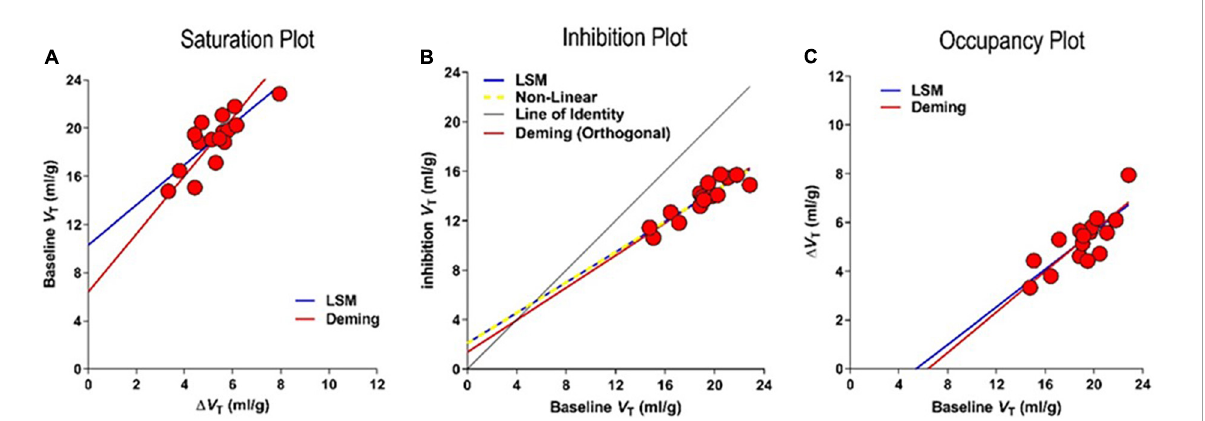
FIGURE11 Competition of tracer [ 18 F]ASEM with unlabeled inhibitors. Results of regressions to three different linearizations of competition plots of effect of unlabeled drug interaction with PET tracer binding in absence of valid reference region. (A) Saturation Plot of baseline V T vs. change of V T with inhibition. (B) Inhibition Plot of baseline vs. inhibition V T yielding saturation s as 0.39 ± 0.077 and non-displaceable volume V ND as 5.4 ± 2.75 ml/gm (C) Occupancy Plot of change of V T vs. baseline V T (adapted from Horti et al., 2014; Khodaii et al.,